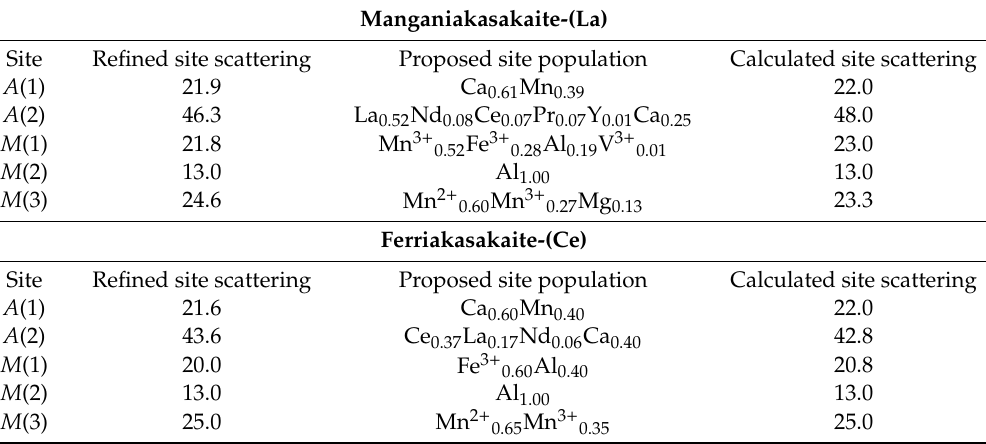
Table 7. Refined site scattering vs. calculated site scattering (in electrons) and site population at the A and M sites in manganiakasakaite-(La) and